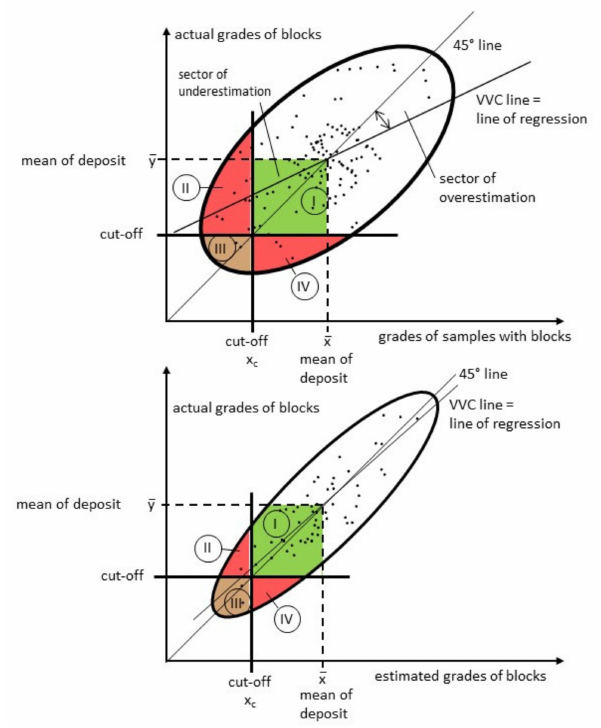
Figure 10. Hypothetical frequency distribution for drill-hole samples and corresponding mining blocks (from Wellmer, 1996 [29]). Because of the different support and larger variance of the drill holes than those of the blocks, the mean of the upper half of the frequency distribution of the drill holes, m h (ddh), is larger than the mean of the upper half of the blocks m h (blocks), and vice versa for the lower halves of the frequency distributions of drill holes and blocks, m l (ddh) vs. m l (blocks).